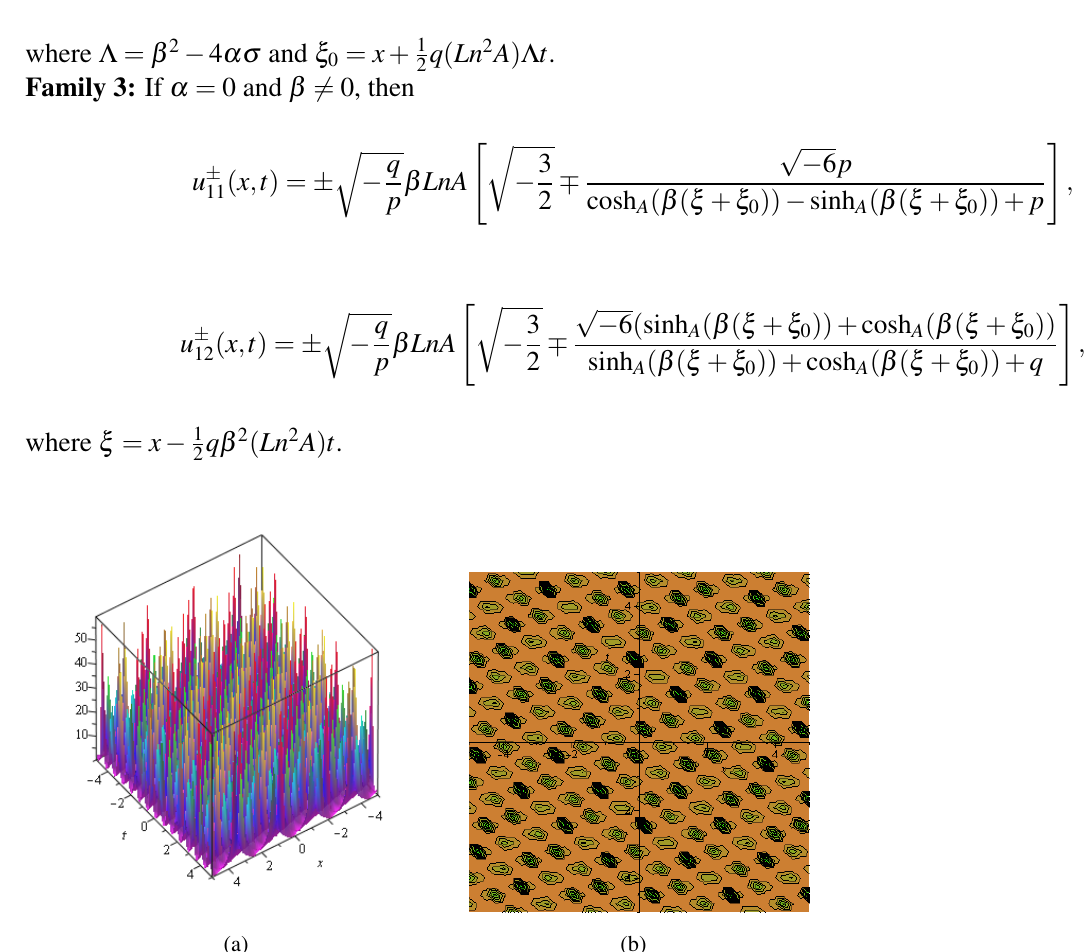
( x , t ) ) corresponding to the values 1